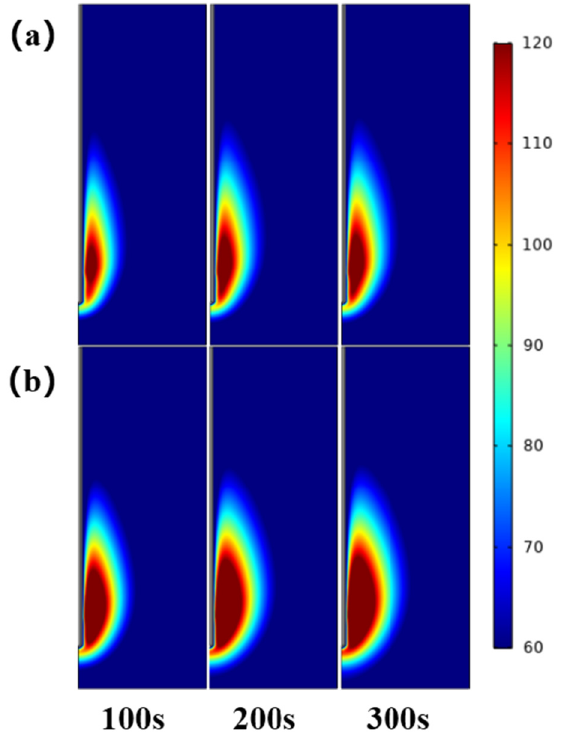
Figure 9. Thermal field distribution of microwave ablation (Power = 50 W, ( a ) inflated group; ( b ) deflated group).